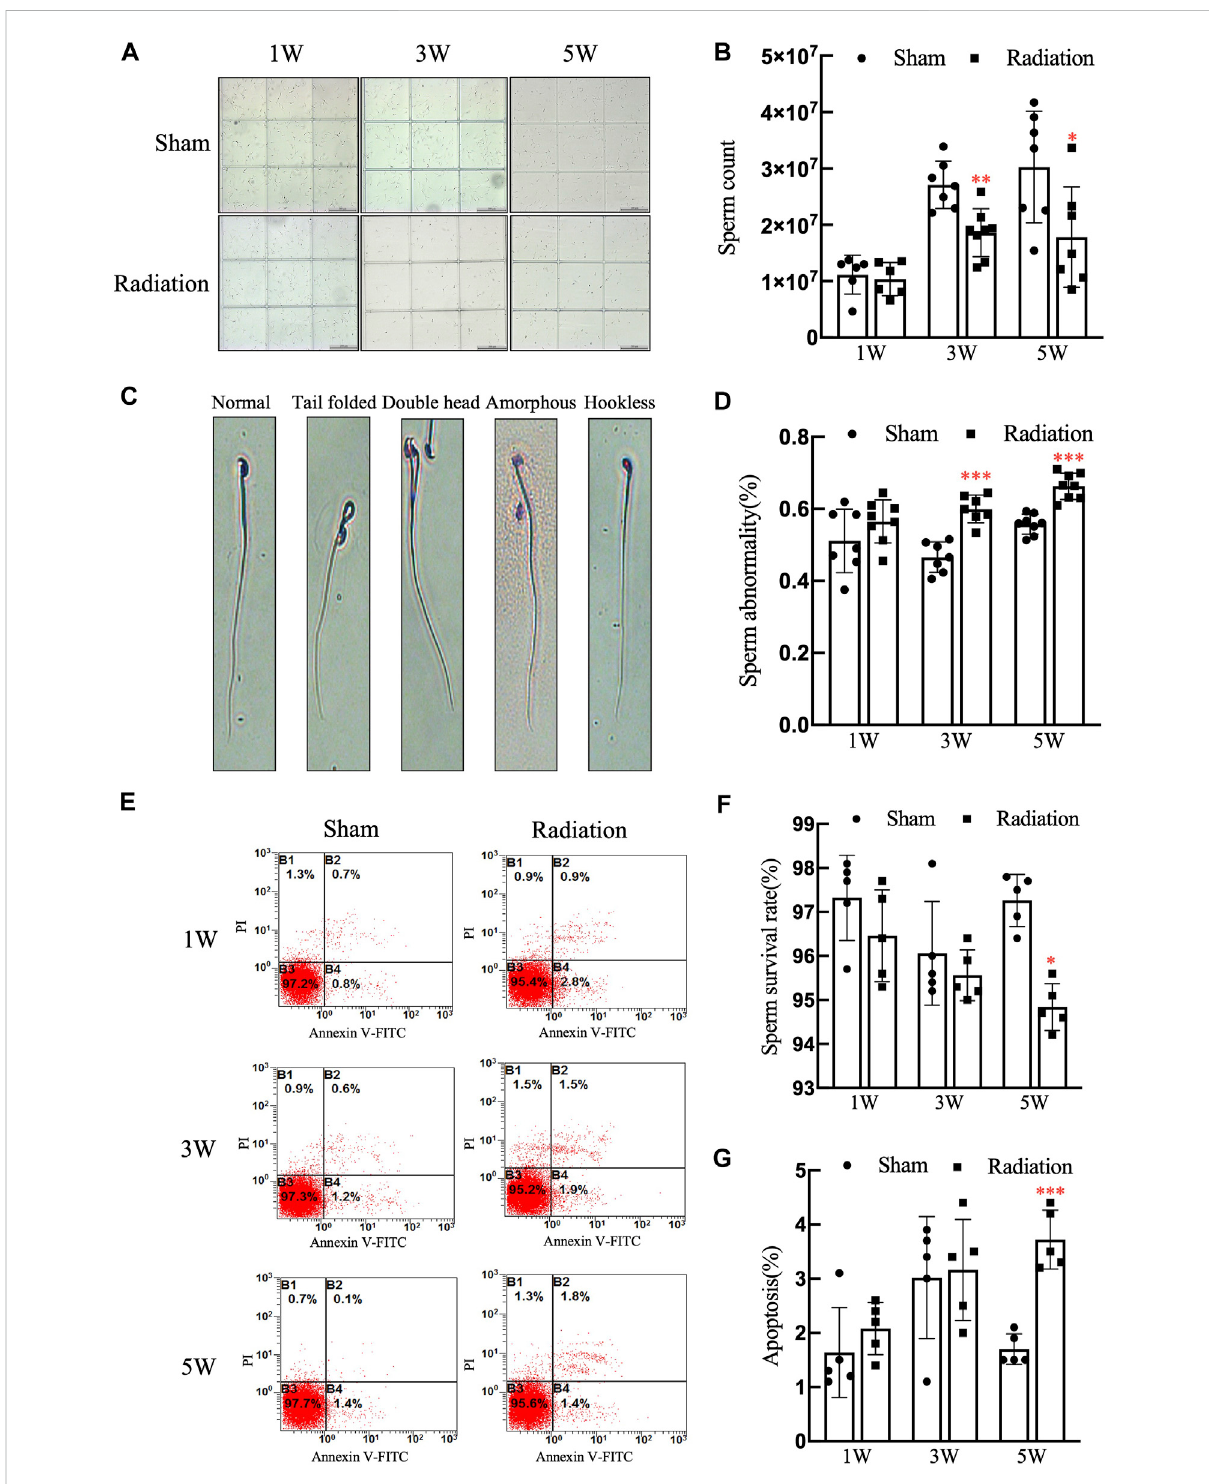
FIGURE 4 Abscopal effects of thoracic X-ray irradiation on sperm quality in mice (A) Representative pictures of sperm count, Bar = 200 μ m (×100). (B) Analysis of sperm count. n = 7 for each group. (C) Typical types of abnormal sperm morphology, including the folded-tail, hookless, amorphous, double-head and double-tail phenotypes. (D) Sperm abnormality, n = 7 for each group. (E) Representative pictures of sperm apoptosis detected by FCM. (F,G) Survival rate, apoptosis rate of sperm, n = 5 for each group. The values are expressed as the mean ± SD, * p < 0.01; ** p < 0.01; *** p < 0.001 vs. sham